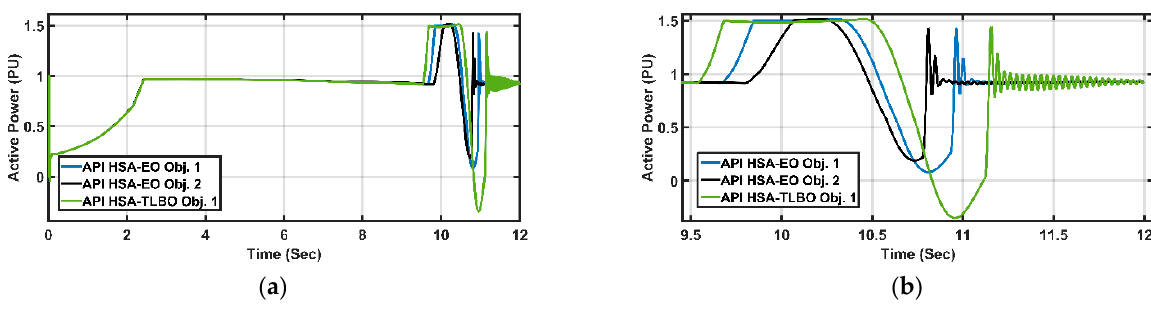
Figure 19. ( a ) Active power responses of normal third case. ( b ) Focusing active power responses of normal third case.